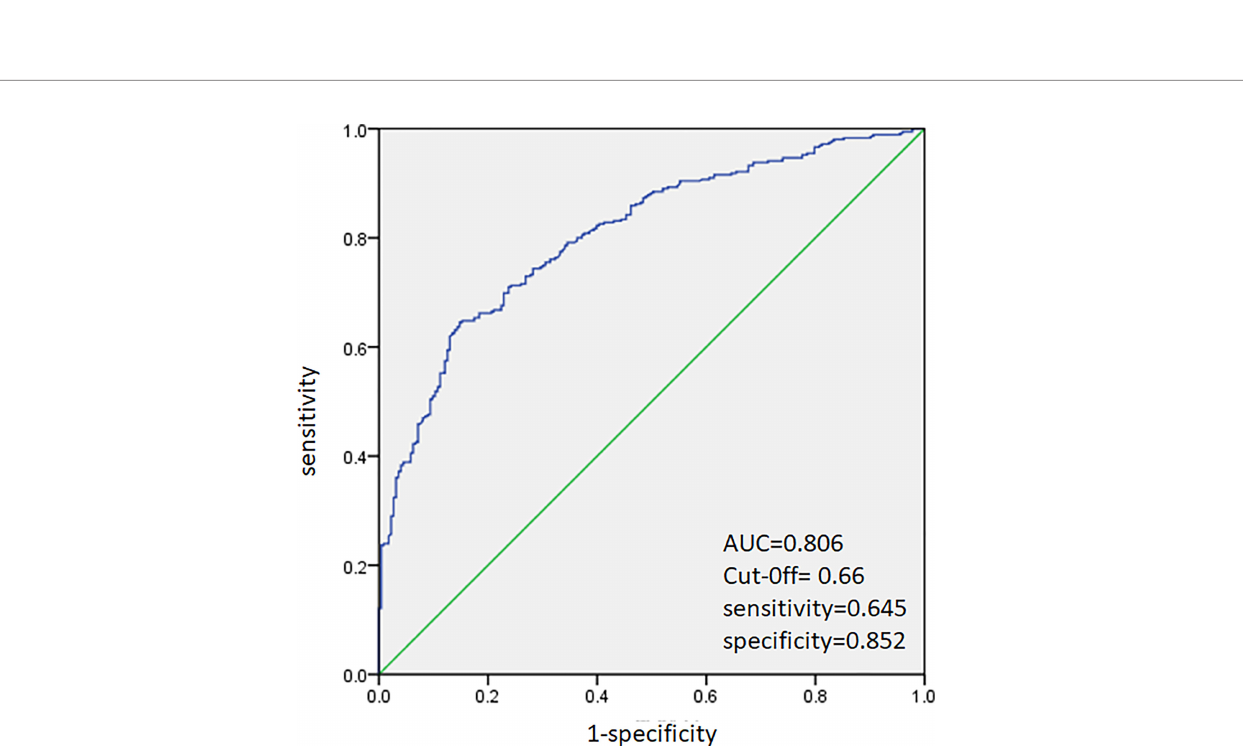
Frontiers in Endocrinology |